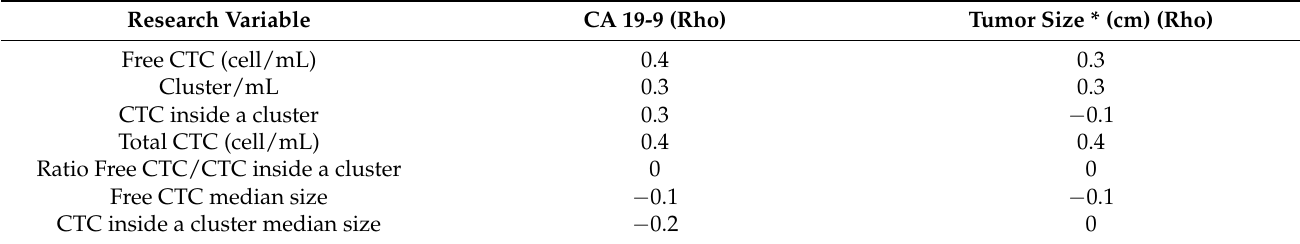
Table 5. Tumor and CA 19-9 preoperatively evaluated by CTC characteristics with Spearman correlation coefficient (Rho) (PV measurements).